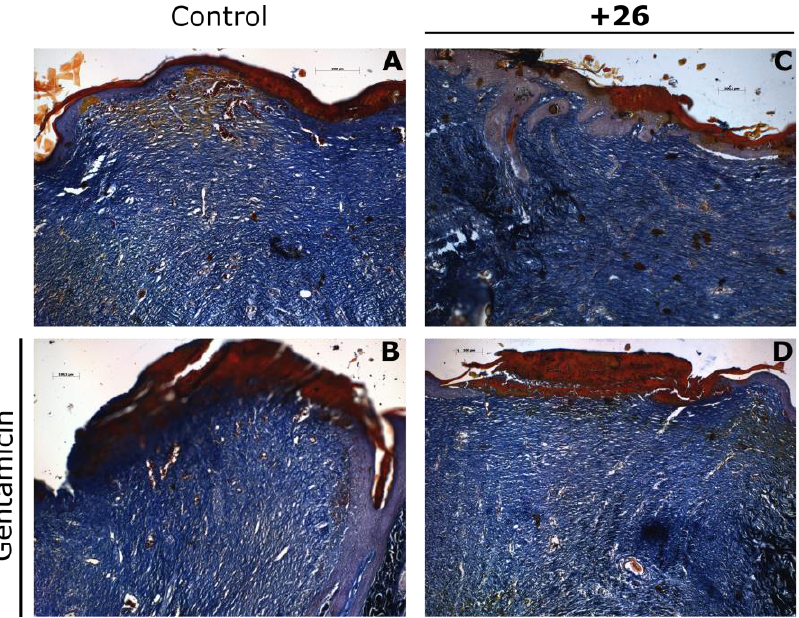
Figure 8. Histological analysis of rat skin areas subjected to infection and treated for 15 days with vehicle gel ( A ), gentamicin ( B ), 26 ( C ), and 26 combined with gentamicin ( D ). Scale bar is 100 µm. Samples were fixed in 10% formalin and collagen fibers were stained according to Mallory’s protocol.